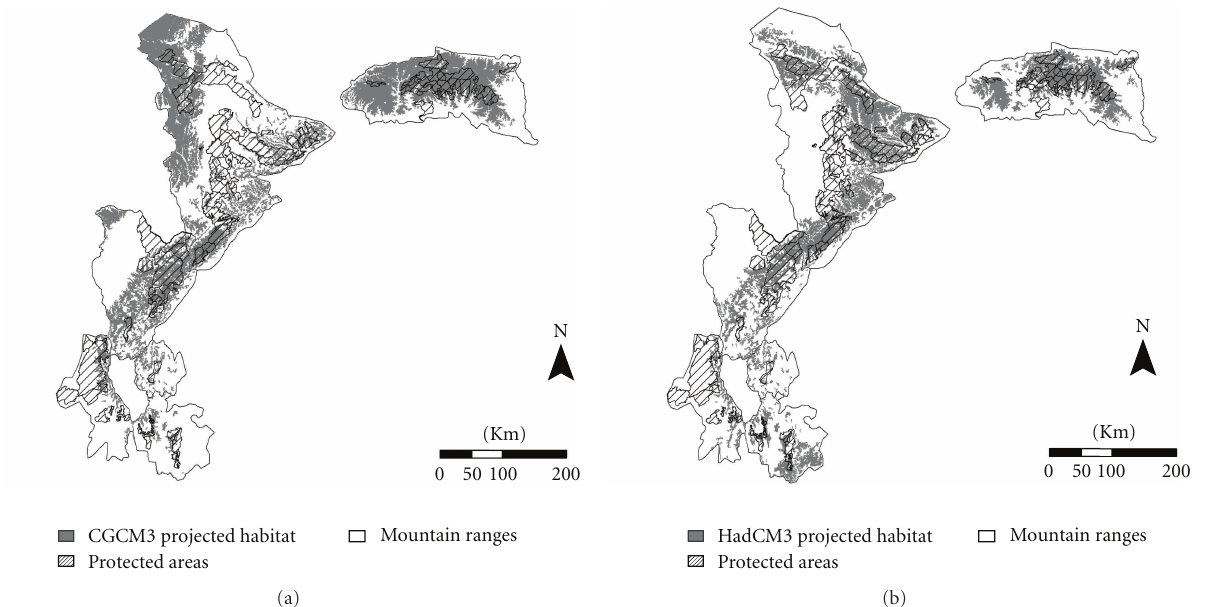
Figure 2: Predicted suitable habitat for the year 2080 based on (a) Canadian Centre for Climate Modeling and Analysis Coupled Model, version 3 (CGCM3), (b) Hadley Center for Climate Modeling Coupled Model, version 3 (HadCM3), and protected status based on the existing protected area system. Table 3: Fragmentation metrics for the current and future suitable habitat for giant panda based on the Canadian Centre for Climate Modeling Analysis (CGCM3) and Hadley Center for Climate Modeling (HadCM3). Mean patch size (km 2 Range